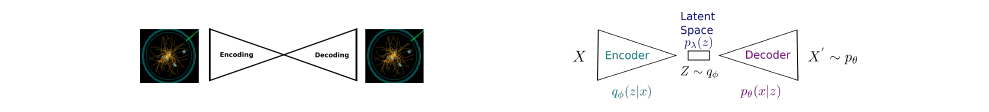
Figure 1. Basic autoencoding (left). Structure of a variational autoencoder (right).